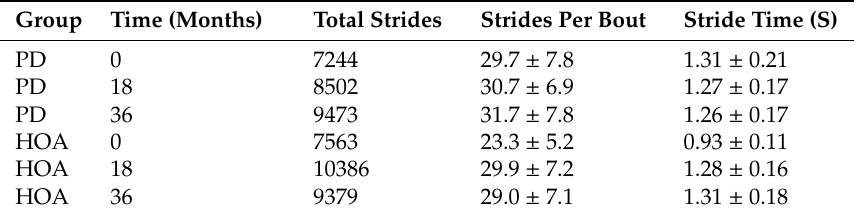
Table 2. Average number of strides analyzed, average strides per bout, and average stride time at time-points 0, 18, and 36 months.